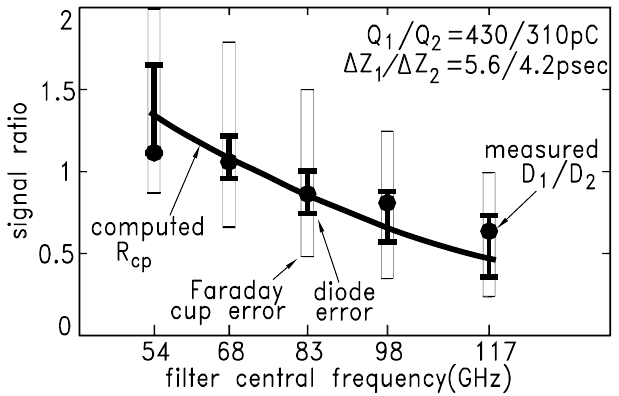
FIG. 10. Comparison of the computed R =D D for each channel (fixed wavelength) for two different 1 2 bunch lengths (5.6 and 4.2 psec) and charges (430 and 310 pC). The solid black line is the computed R bunch charges, and rms lengths by an independent technique. The dots represent the measured D from one shot to another measured by a Faraday cup results in large vertical error bars (hollow bars). The variation in charge derived from the signal variation of the detector, on contrary, results in smaller error bars (diode error) (see explanation in the